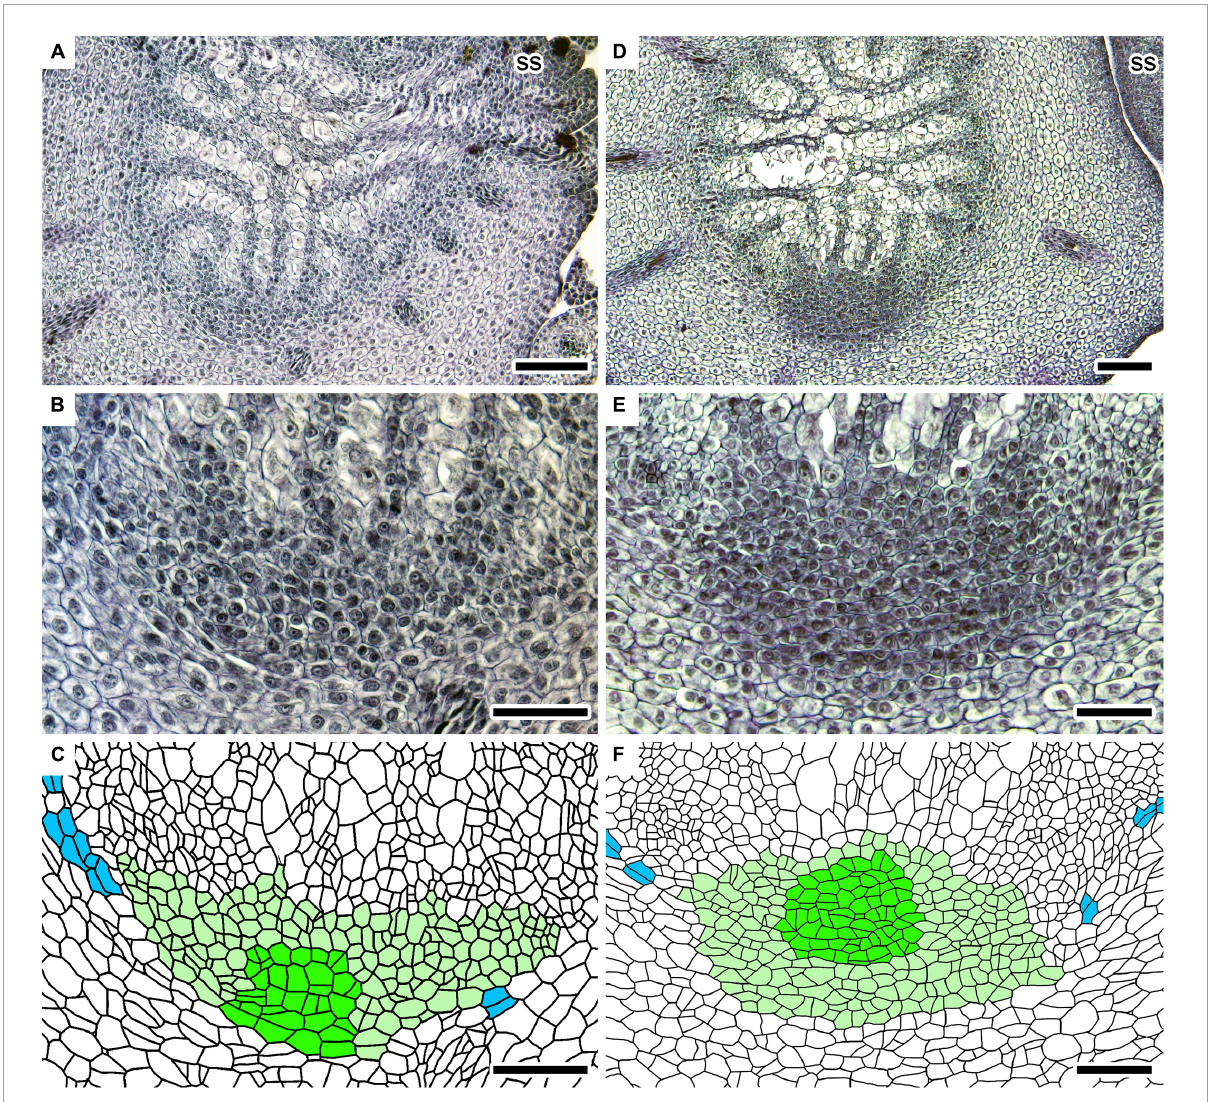
FIGURE5 Root developing processes in two independent shoots of Lycopodium clavatum . (A–C) In sample #2–11. Cross-sections at 1,040 µ m from the shoot apex. (B) Close-up of (A) showing root primordium. (C) Line drawing of (B) . (D–F) In sample #2–33. Cross-sections at 1,450 µ m from the shoot apex. (E) Close-up of (D) showing root primordium. (F) Line drawing of (E) . Scale bars, 100 µ m in (A,D) ; 50 µ m in (B,C,E,F) . ss: small shoot. See Figure 4 for color legend in line